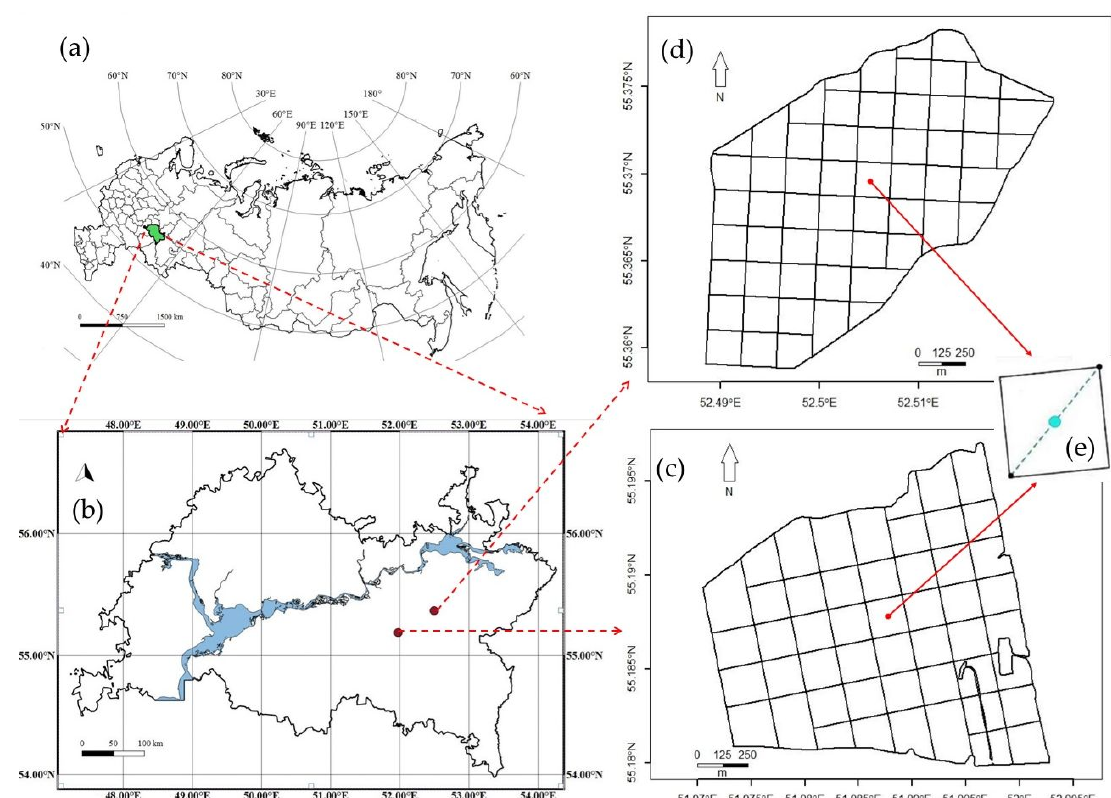
Figure 1. Location of research objects: ( a ) map of Russian Federation, ( b ) map of Republic of Tatarstan, ( c ) field for training of model ( d ) field for testing of model, ( e ) element of sampling area with a design of soil sampling. The dot marks the location of the geographical reference of the mixed sample.